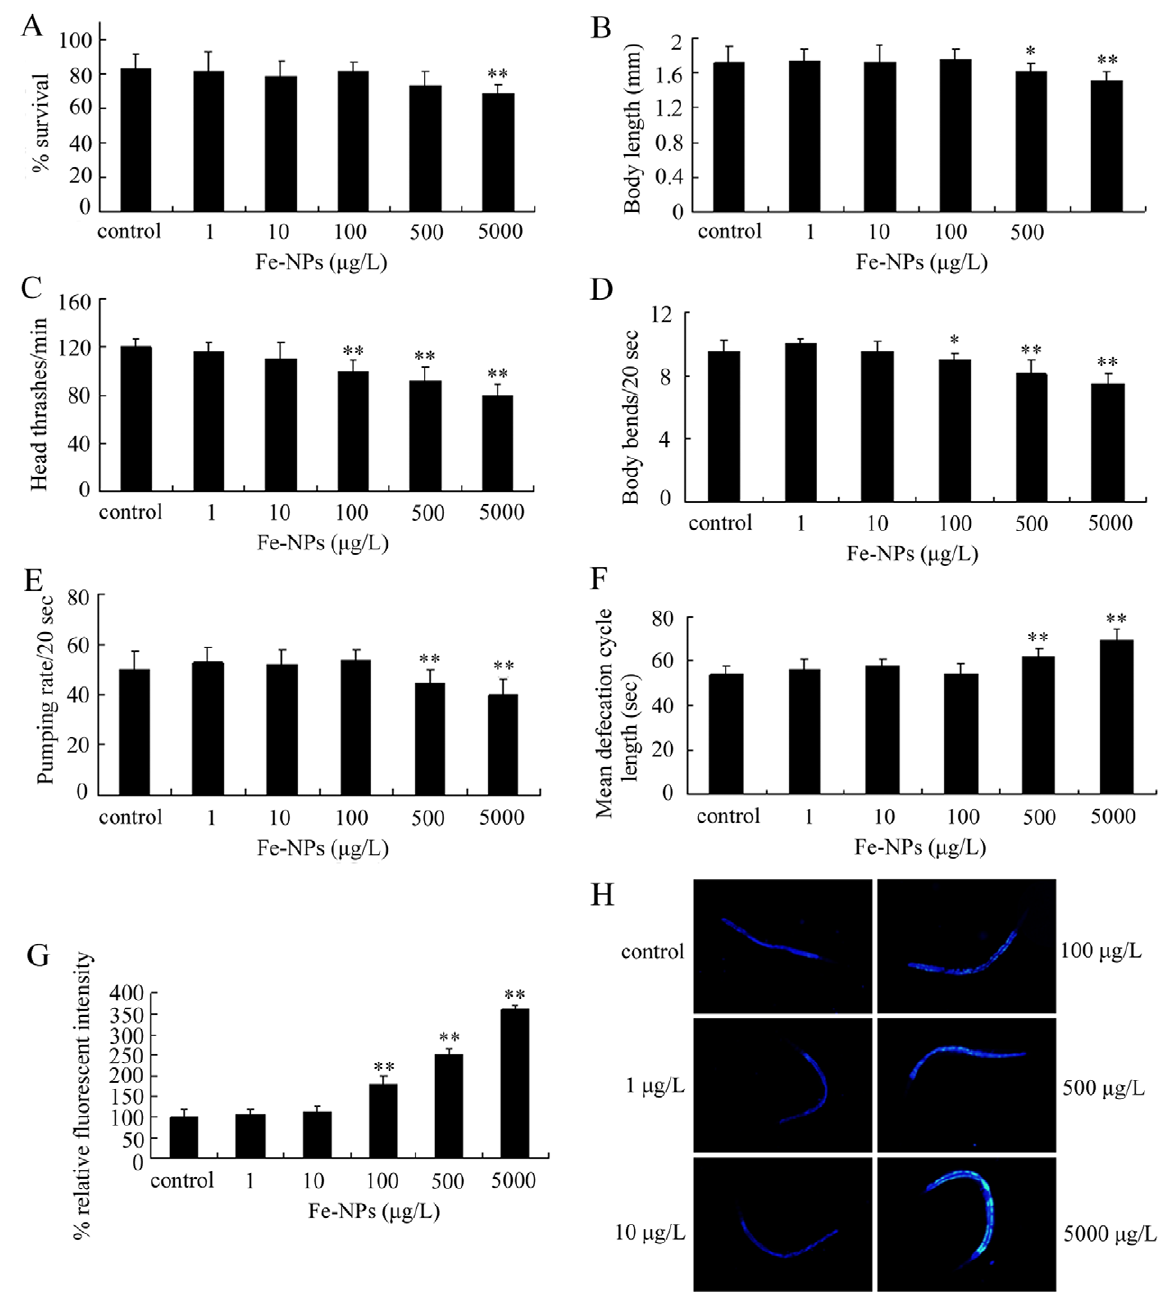
Figure 3. Toxicity evaluation in nematodes exposed to DMSA coated Fe2O3-nanoparticles from L1-larvae to day-8 adult. (A) Comparison of lethality in nematodes exposed to different concentrations of Fe 2 O 3 -nanoparticles. (B) Comparison of body length in nematodes exposed to different concentrations of Fe 2 O 3 -nanoparticles. (C) Comparison of head thrash in nematodes exposed to different concentrations of Fe 2 O 3 -nanoparticles. (D) Comparison of body bend in nematodes exposed to different concentrations of Fe 2 O 3 -nanoparticles. (E) Comparison of pumping rate in nematodes exposed to different concentrations of Fe 2 O 3 -nanoparticles. (F) Comparison of mean defecation cycle length in nematodes exposed to different concentrations of Fe 2 O 3 -nanoparticles. (G) Comparison of intestinal autofluorescence in nematodes exposed to different concentrations of Fe 2 O 3 -nanoparticles. (H) Pictures showing the intestinal autofluorescence in nematodes exposed to different concentrations of Fe 2 O 3 -nanoparticles. Bars represent mean 6 S.E.M. * p , 0.05, ** p , 0.01. doi:10.1371/journal.pone.0043729.g003 lfuorescence as the dependent variables and with ROS production thrash (R 2 = 0.842, p , 0.05), pumping rate (R 2 = 0.863, p , 0.01), as the independent variable, after DMSA coated Fe 2 O 3 -NPs mean defecation cycle length (R 2 = 0.884, p , 0.01), and intestinal exposure from L1-larvae to adult, ROS production was signifi- autofluorescence (R 2 = 0.993, p , 0.01) (Table S1). With lethality, growth, locomotion behavior, pharyngeal pumping, defecation, cantly correlated with growth (R 2 =0.688, p , 0.05), reproduction (R 2 = 0.881, p , 0.01), body bend (R 2 = 0.739, p , 0.05), head and intestinal autolfuorescence as the dependent variables and